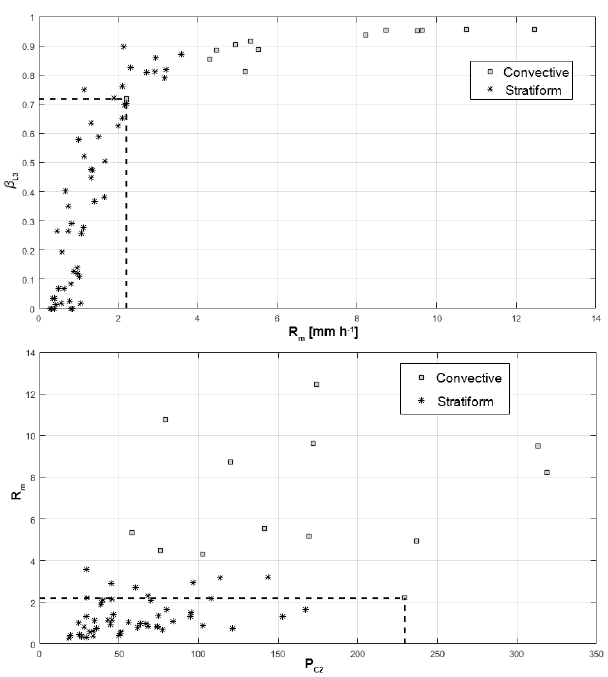
Figure 7. Representation of the neurons in the R m , β L 3 , and R m , P c 2 subspaces. The stars represent neurons from group 1 (strati- form), and the squares correspond to neurons from group 2 (con- vective). Dashed lines indicate the neuron no. 64.